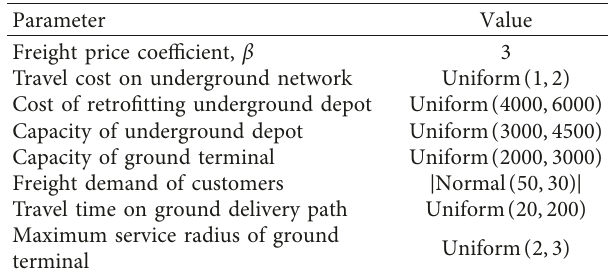
Table 1: Parameters of metro